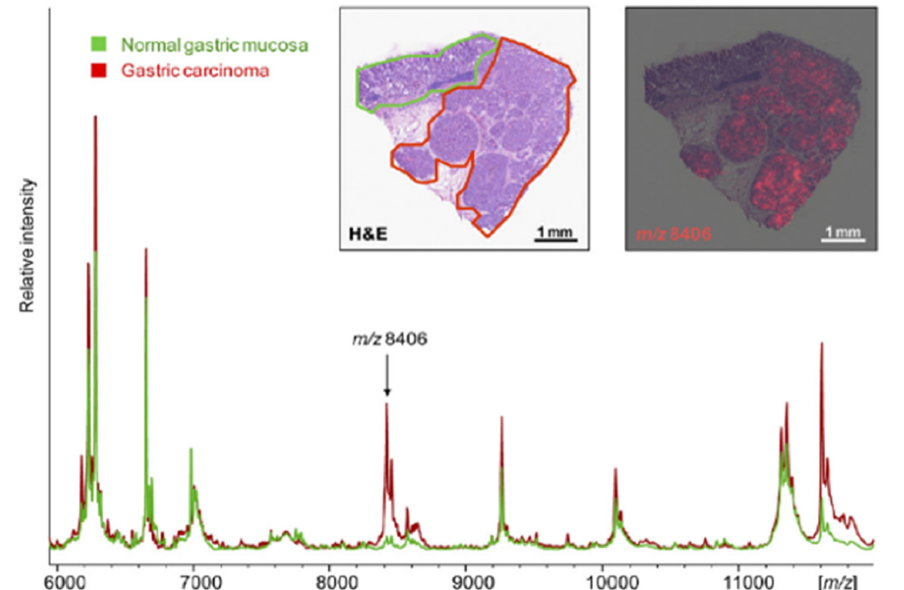
Figure 2. An overview of the use of MALDI mass spectrometry imaging (MSI) in clinical applications. The histological (H&E) staining has revealed the two different regions and MALDI MSI has revealed cell type-specific profiles for gastric carcinoma (red) and normal gastric mucosa (green) from an individual patient’s tissue. The example m/ z 8406 is exclusively present in cancer cells, also indicated on the right inset (red visualization). This protein was also found to correlate significantly with the patient’s overall survival. Adapted with permission from Balluff et al . 2011 (Am. J. Pathol.).